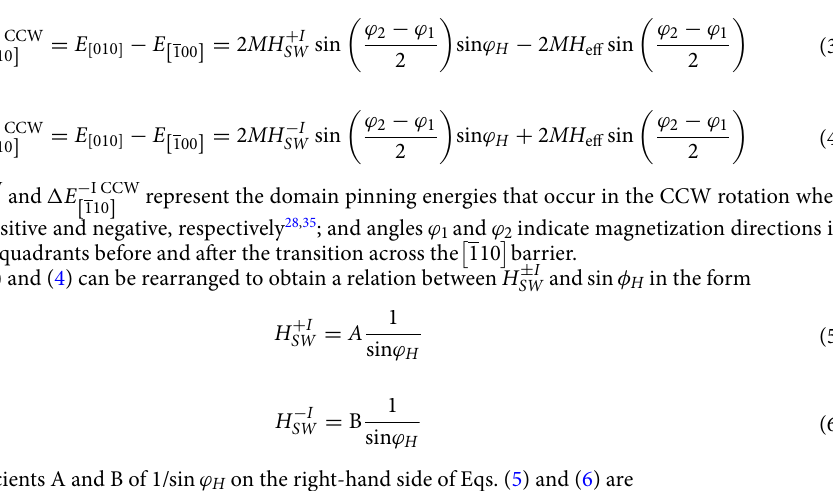
where K U and K C are uniaxial and the cubic anisotropy coefficients, respectively. The effective SOI field and external magnetic field are expressed as H eff and H , respectively. The orientations of magnetization ϕ M , exter- 110 nal field ϕ H , and effective SOI field ϕ eff are measured from the direction (i.e., from the current direction). The Dresselhaus-type (Rashba-type) SOI field in the GaMnAs film is at ϕ eff = − π 2 ( ϕ eff = + π 2 ) when the (cid:31) (cid:30) 110 current flows along the direction (i.e., positive current), and at ϕ eff = + π 2 ( ϕ eff = − π 2 ) for the current along 110 (negative current), as shown in Fig. 1c. Since the Dresselhaus- and Rashba-type fields are always opposite (cid:31) (cid:30) to each other, with this current configuration we only measure the combined effects of these two fields (i.e., their (cid:31) (cid:30) net value). The direction of the net field is consistent with Dresselhaus-type SOI fields, as already mentioned. + I H − I The presence of this H eff then causes the difference in the switching fields H SW and SW , that is observed with positive and negative currents, as already shown in Figs. 2 and 3. In what follows we will use this behavior for obtaining the value of the SOI field quantitatively. In order to develop an expression for the SOI field, let us consider the CCW reorientation of magnetization 110 over the barrier (i.e., the case of transition observed in the negative field regions shown in Fig. 2). The two directions of magnetization involved in these transitions are determined by the two neighboring minima of free (cid:31) (cid:30) 110 energy on both sides of the direction. The energy difference between these minima can be obtained from Eq. (2) for the CCW rotation, as follows: (cid:31) (cid:30)